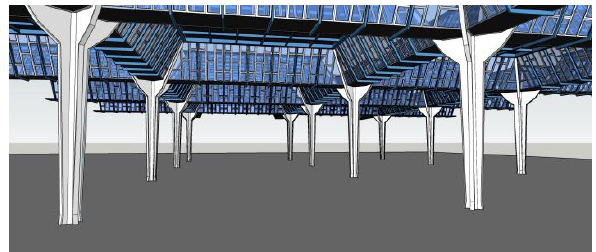
Figure 13: a perspective view of the Olivetti’s Officina H in Ivrea.